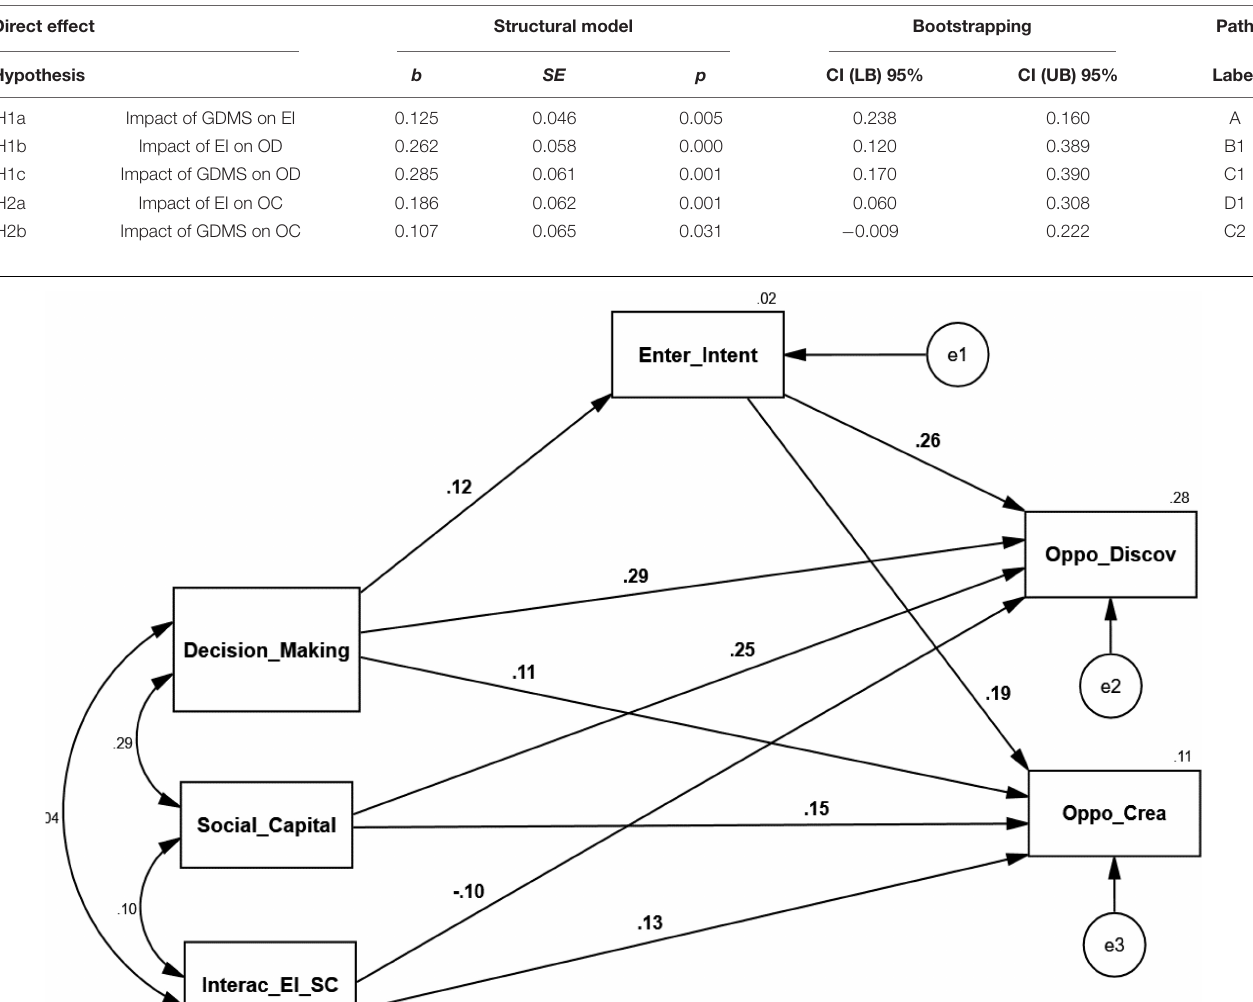
TABLE 4 | Hypothesis testing for the direct effects.